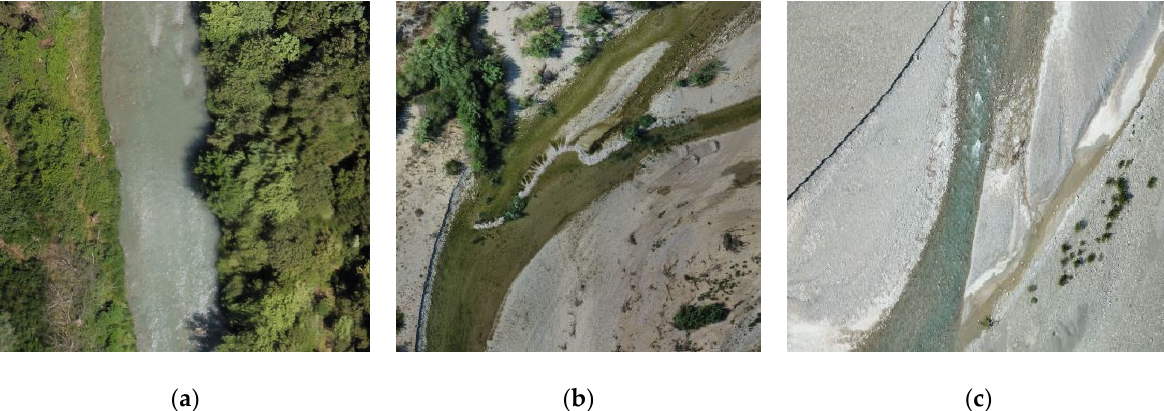
Figure 2. High spatial resolution’s orthophotomaps of 3 different sites: ( a ) Matesi, ( b ) Ladon, and ( c ) Sarantaporos by DJI Mavic Pro.